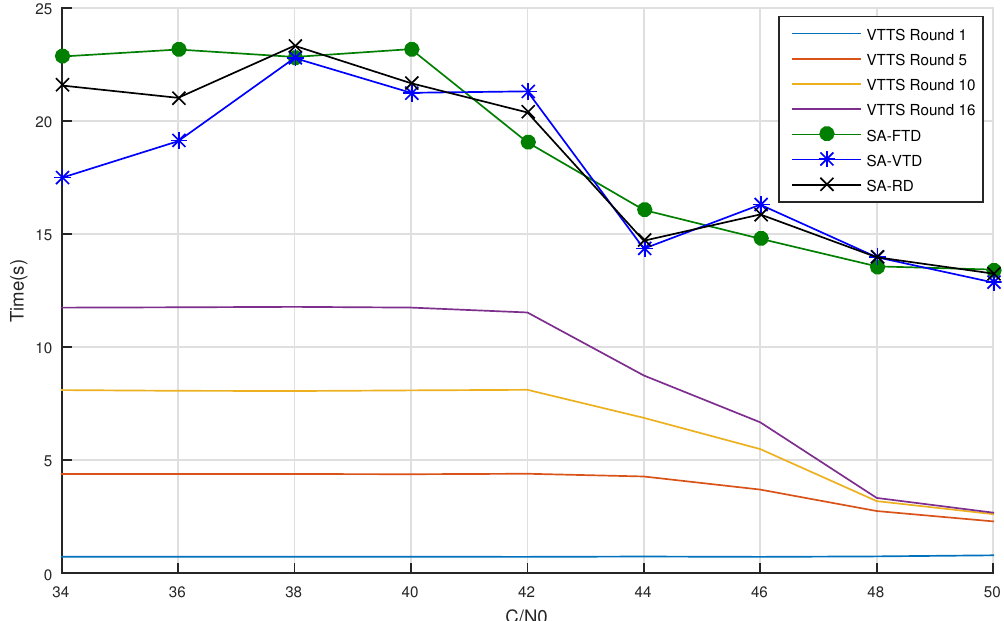
Figure 10. Time to detection for the three SA versions and VTTS acquisition with the maximum number of detection rounds equal to 1, 5, 10 and 16. Table 1. This table represents the time to acquisition vs C/N0 for the three SA versions and VTTS acquisition with four different rounds (1, 5, 10, 16). The performance of the algorithm was superior in all cases. For round = 1 the VTTS was up to 21 times faster. However, the success rate for this round = 1 is worse than the SA. A better comparison scenario is from round = 5. In this scenario the VTTS was 5.8 times better than the SA in the best C/N0 and 3.7 times better in the worst C/N0 analyzed. When we used round = 16, the gains were 1.85 and 5.05 in the worst and best C/N0 respectively. C/N0